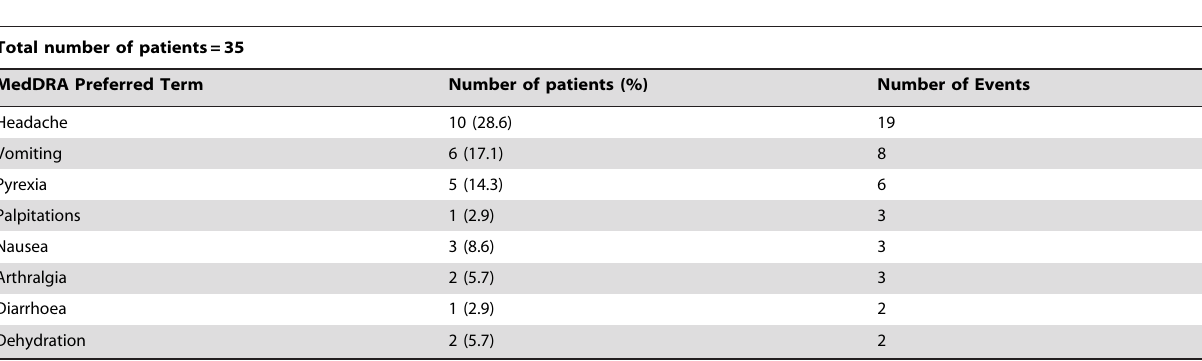
Table 3. List of Adverse Drug Reactions (ADRs) reported on more than one occasion.